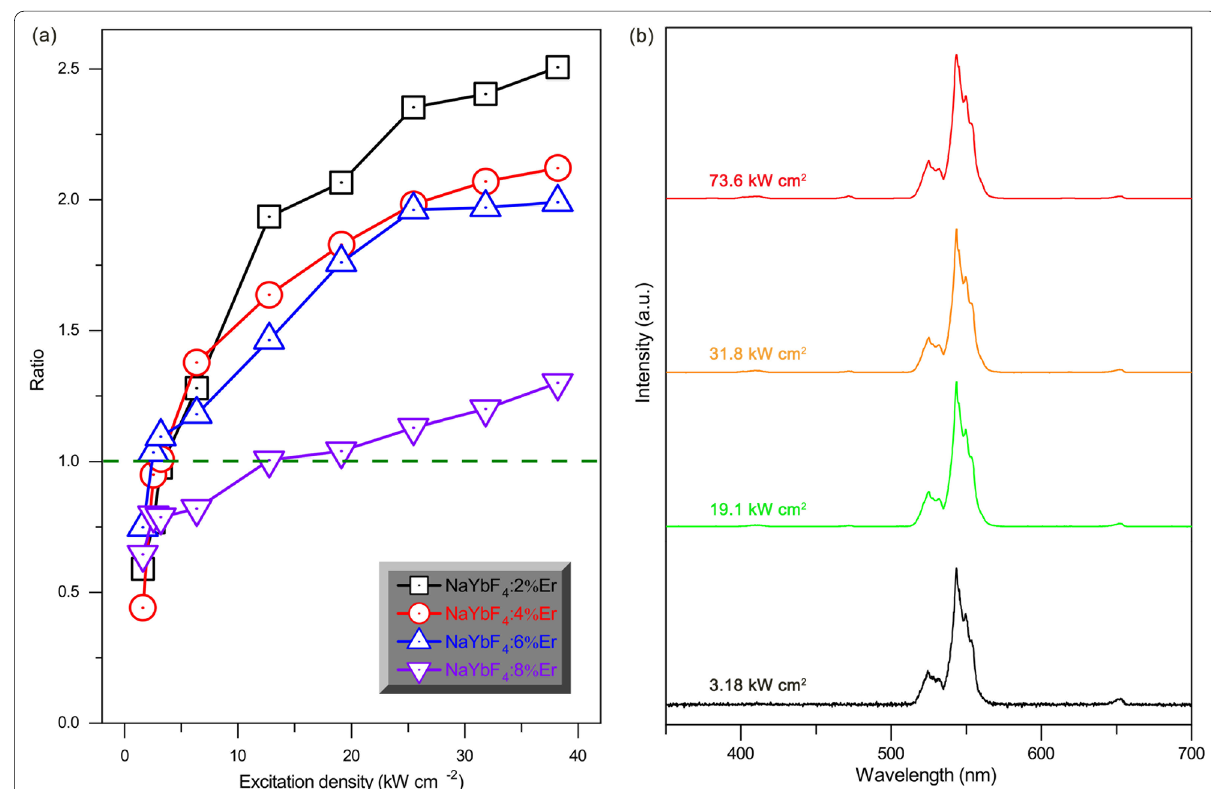
Fig. 4 a The ratios of R / G for single β-NaYbF 4 : x %Er microcrystal doped with different Er 3 + concentrations as a function of the excitation intensity. b The UCL spectra of single β-NaYF 4 :2%Er microcrystal under the excitation of 808 nm CW laser with different excitation